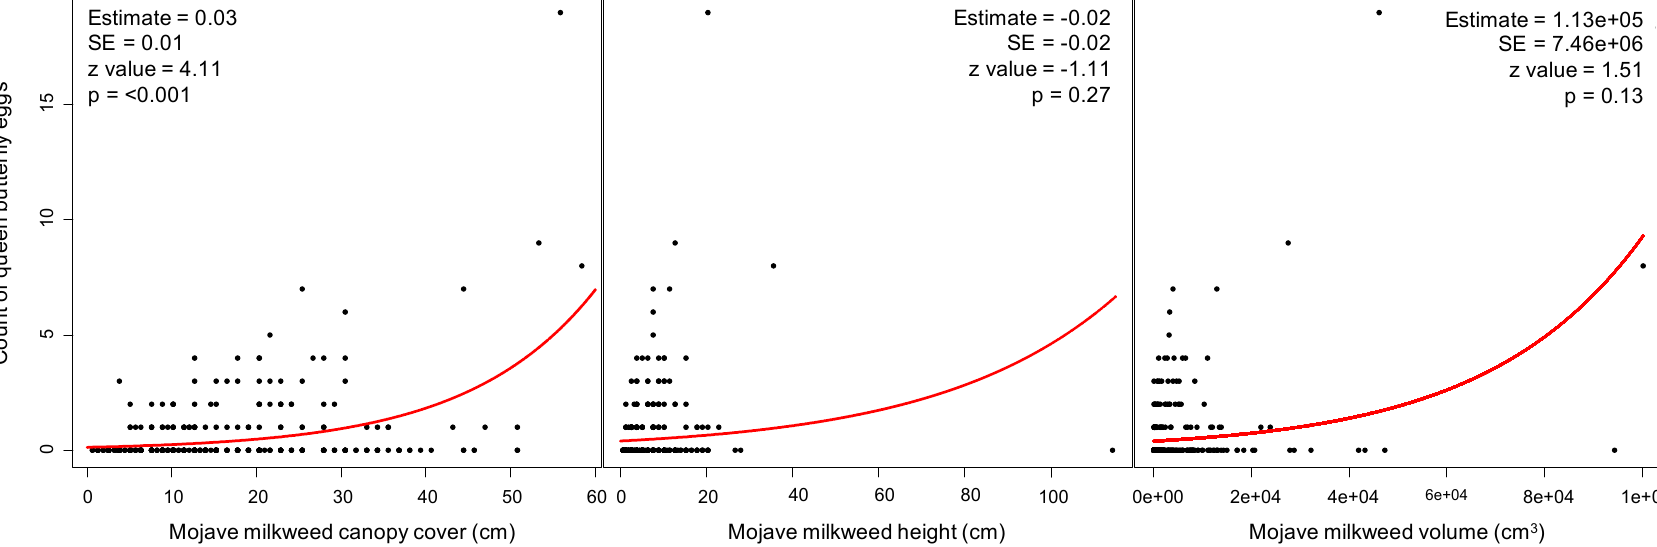
Figure 4. Effects of Mojave milkweed traits on the count of queen butterfly eggs recorded during the spring season, 27 April—1 June 2017, Ivanpah Valley, Mojave Desert, California, USA. Black dots indicate egg count data points and red lines indicate response curves based on the generalized linear model. We set α = 0.05.